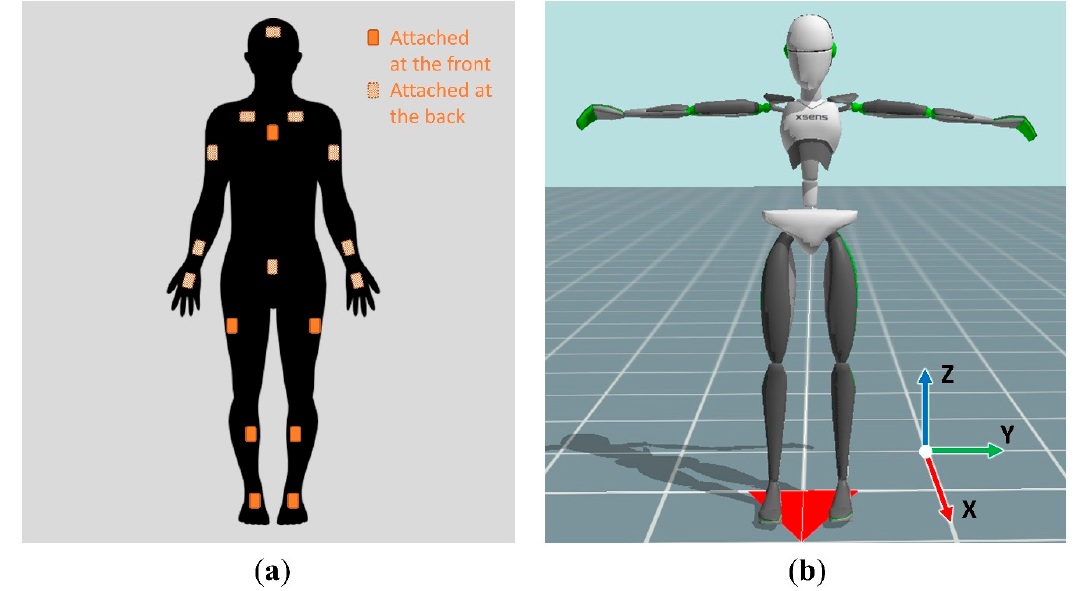
Figure 2. ( a ) Inertial sensor placement in the Xsens MVN Link motion capture system; ( b ) Global coordinates of the human body model built in the Xsens MVN Link.